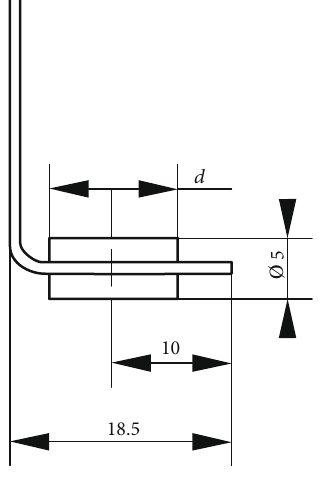
Figure 19: An installation dimension diagram of riveting